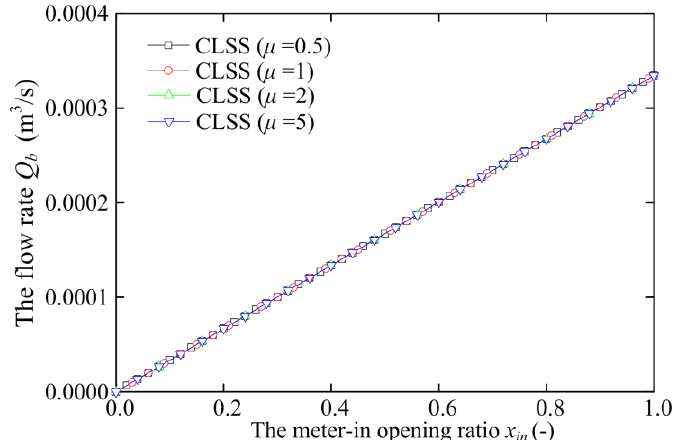
Figure 21. The flow rate Q b of the cylinder rod chamber of CLSS with retraction working mode.